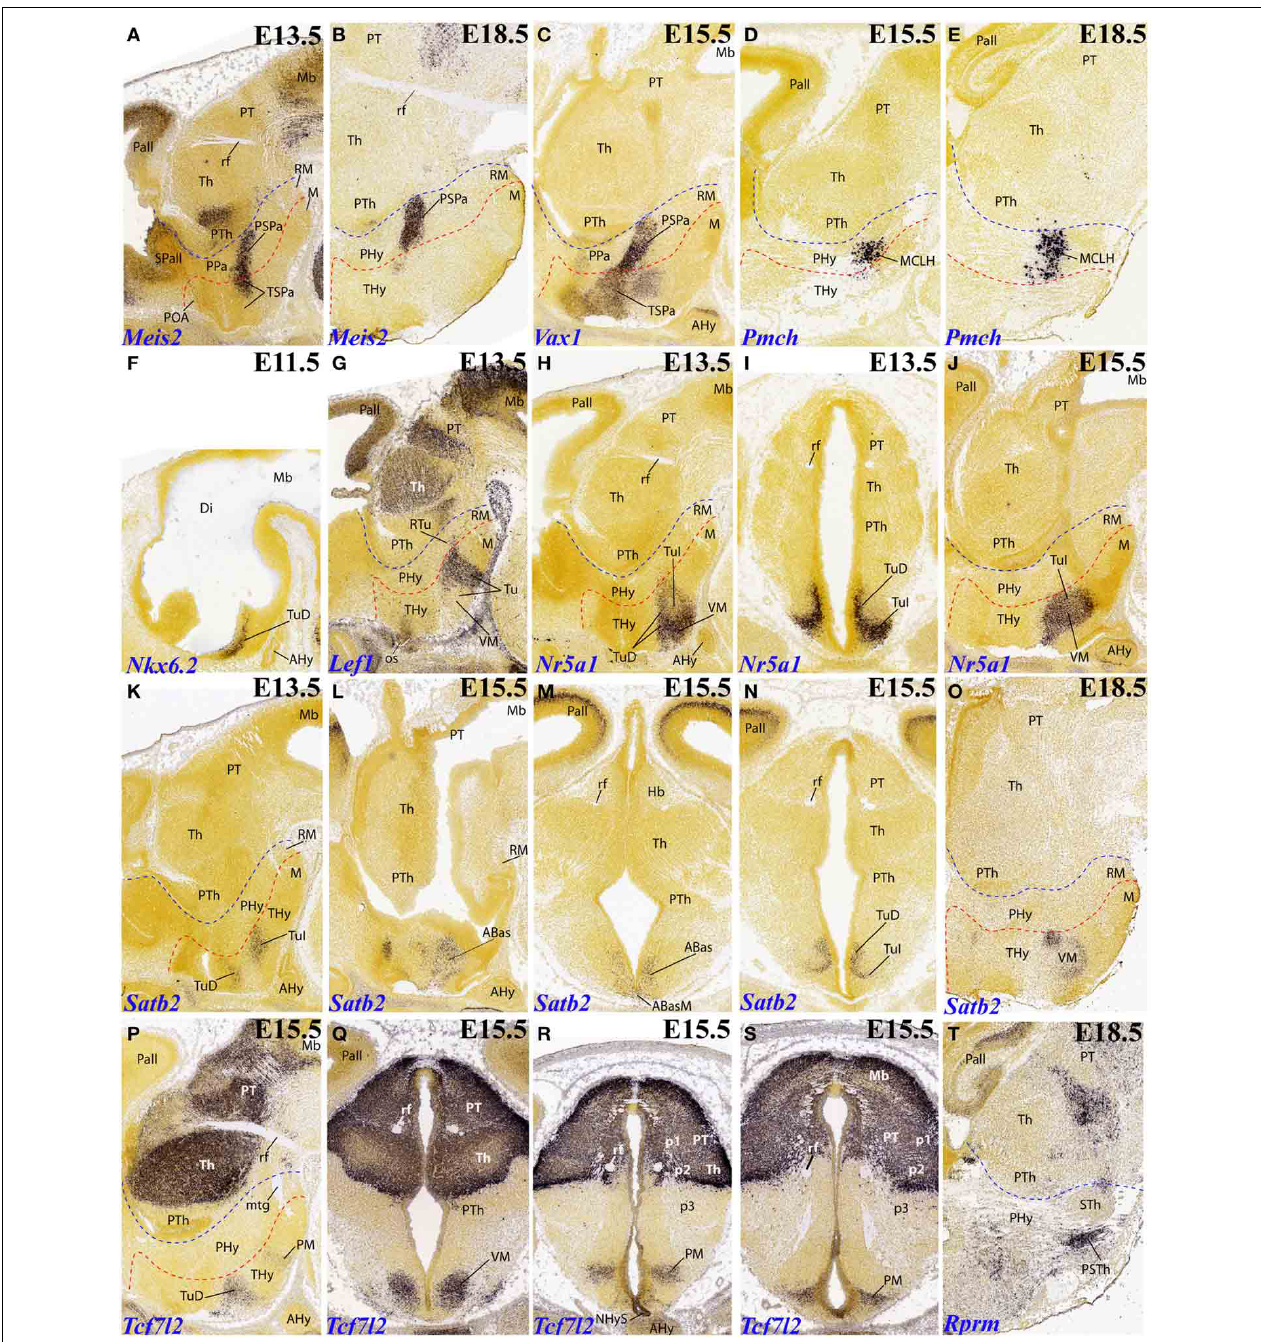
territories: Meis2 (A,B), Vax1 (C), Pmch (D,E), Nkx6.2 (F), Lef1 (G), Nr5a1 (H–J), Satb2 (K–O), Tcf7l2 (P–S), and Rprm (T). All images were downloaded from the Allen Developing Mouse Brain Atlas (http://developingmouse.brain-map.org/). For abbreviations, see the list. Red dotted line: THy/PHy boundary. Blue dotted line: PHy/p3 boundary.